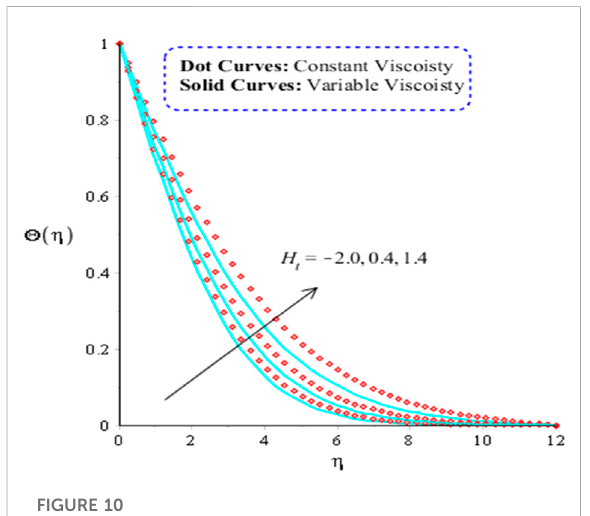
FIGURE 10 Variation in temperature fi eld versus H t .